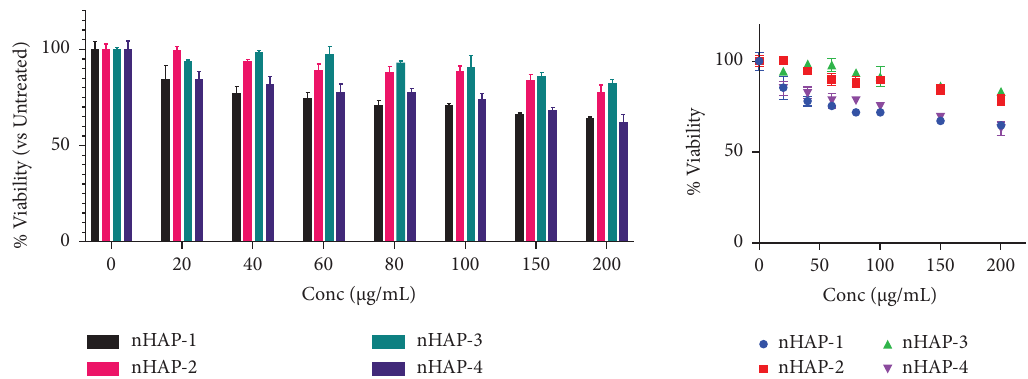
Figure 4: In vitro cytotoxicity of nHAP constructs in NIH 3T3 fbroblast